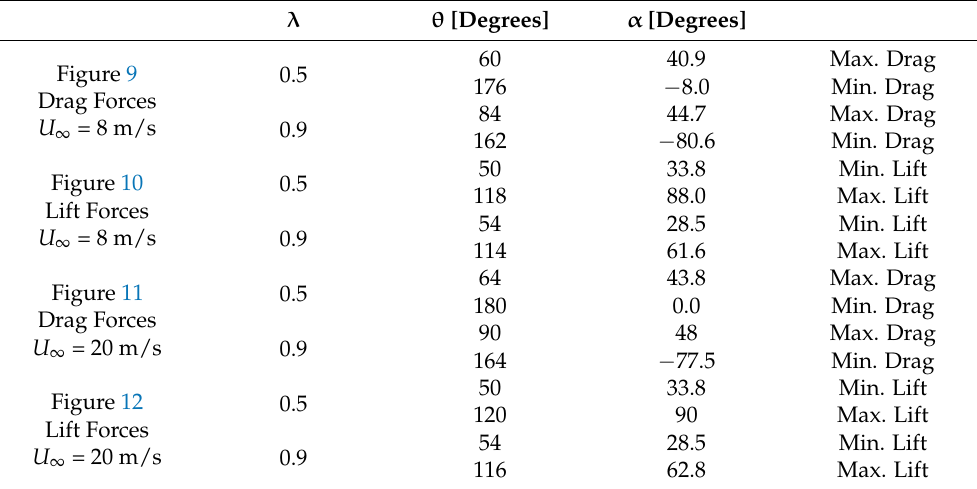
Table 7. Summary of Maximum and Minimum Drag and Lift Forces on the Blade 1 for U ∞ = 8 m/s and U ∞ = 20 m/s at both λ = 0.5 and λ = 0.9.